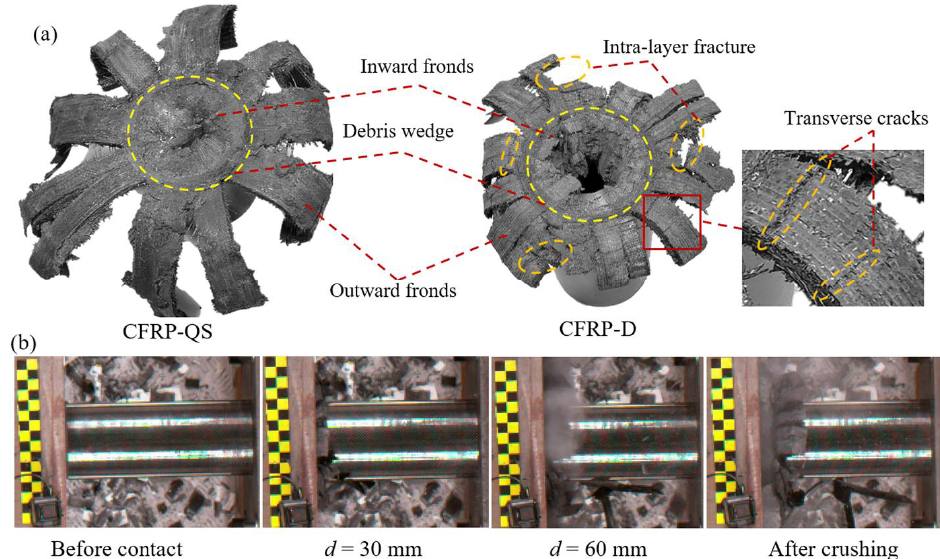
Figure 3. ( a ) Crushing failure modes and ( b ) crushing process of CFRP-D.